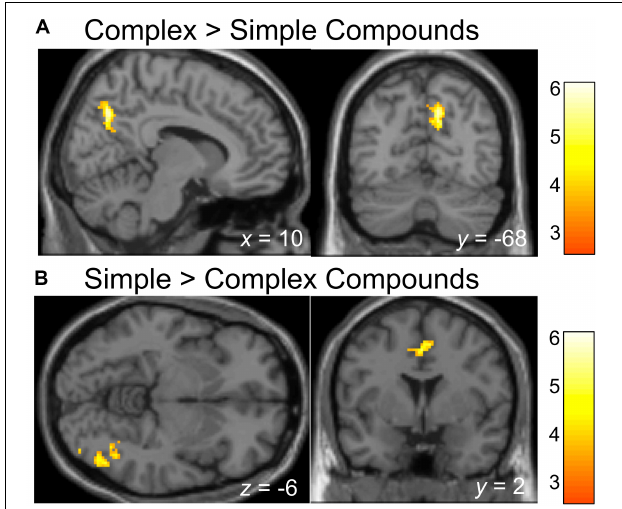
FIGURE 3 | Brain regions showing activation difference when processing Simple compared to Complex compounds. Activation maps are rendered on a brain template depicting regions showing higher activation during the processing of Complex compared to Simple Compounds (A) , or higher activation during the processing of Simple compared to Complex Compounds (B) . The threshold for depicting effects in activation map was set at p < 0.001 with 100 contiguous